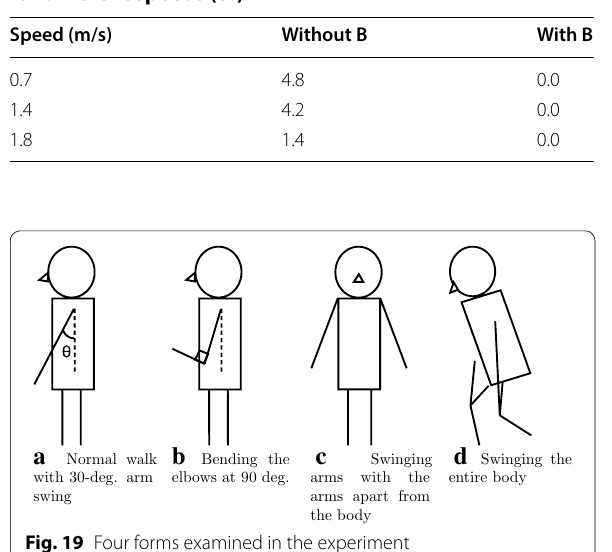
Table 4 Misdetection rates of person detection